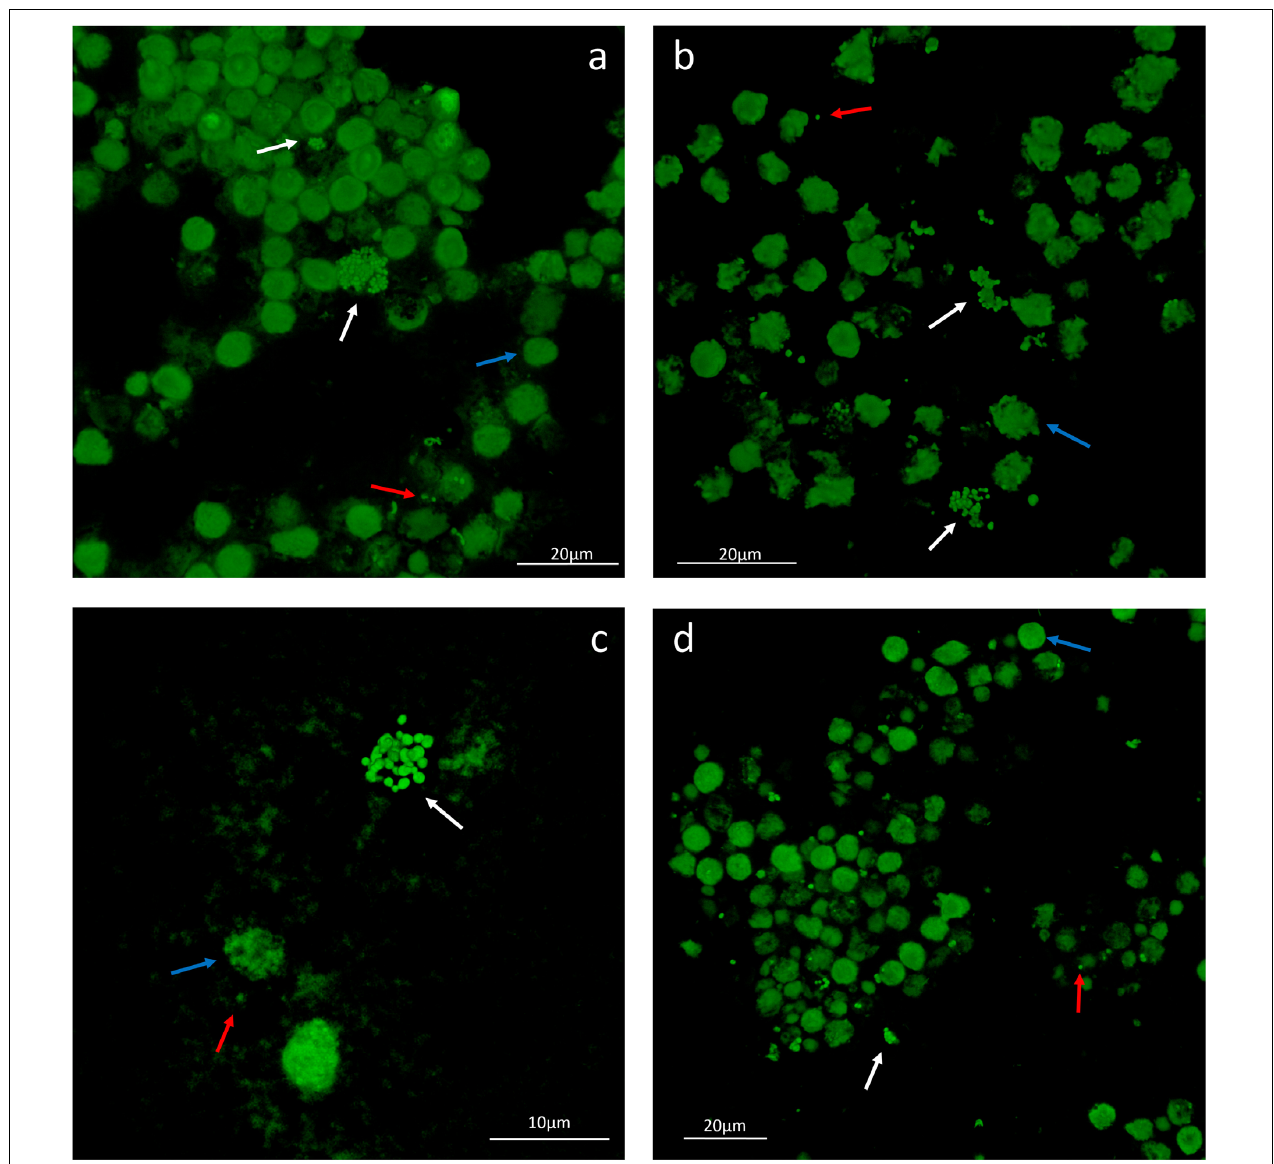
FIGURE 1 | Representative confocal laser scanning microscopy images of infected synovial fluids stained with SYTO 9 nucleic acid stain. (a) Staphylococcus aureus 1, (b) S. aureus 2, (c) S. aureus 3, and (d) Staphylococcus lugdunensis . The white arrows indicate the biofilm-like aggregates of cells, the red arrow indicates the single bacterial cells, and the blue arrows indicate the immune cells